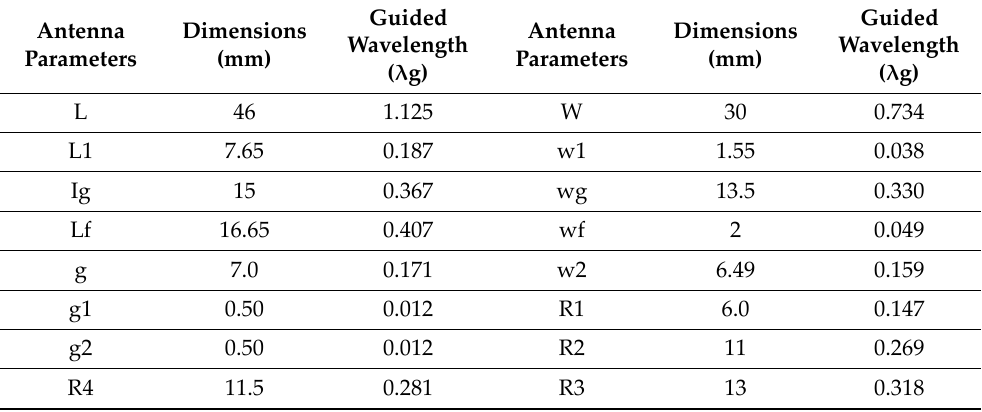
Table 1. Design dimensions of the proposed unit cell